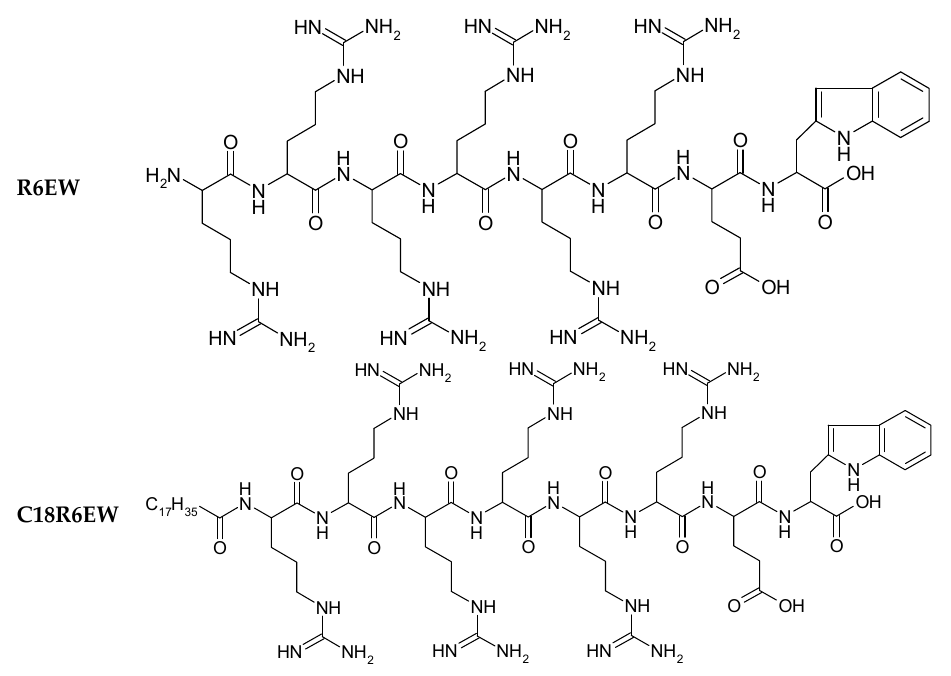
Figure 1. Chemical structure of peptides.